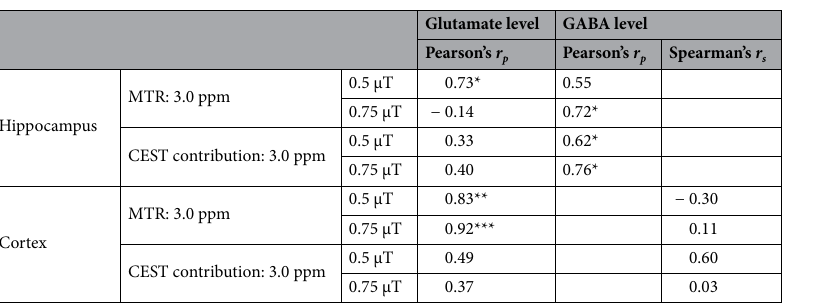
Table 2. Parametric (Pearson’s r p ) and nonparametric (Spearman’s r s ) correlations analysis results. Correlation assessment performed between glutamate and GABA levels obtained in biochemical ELISA tests and MTR and CEST contribution calculated at 3.0 ppm in the cortex and hippocampus of the stressed group (*p < 0.05, **p < 0.01 and ***p <